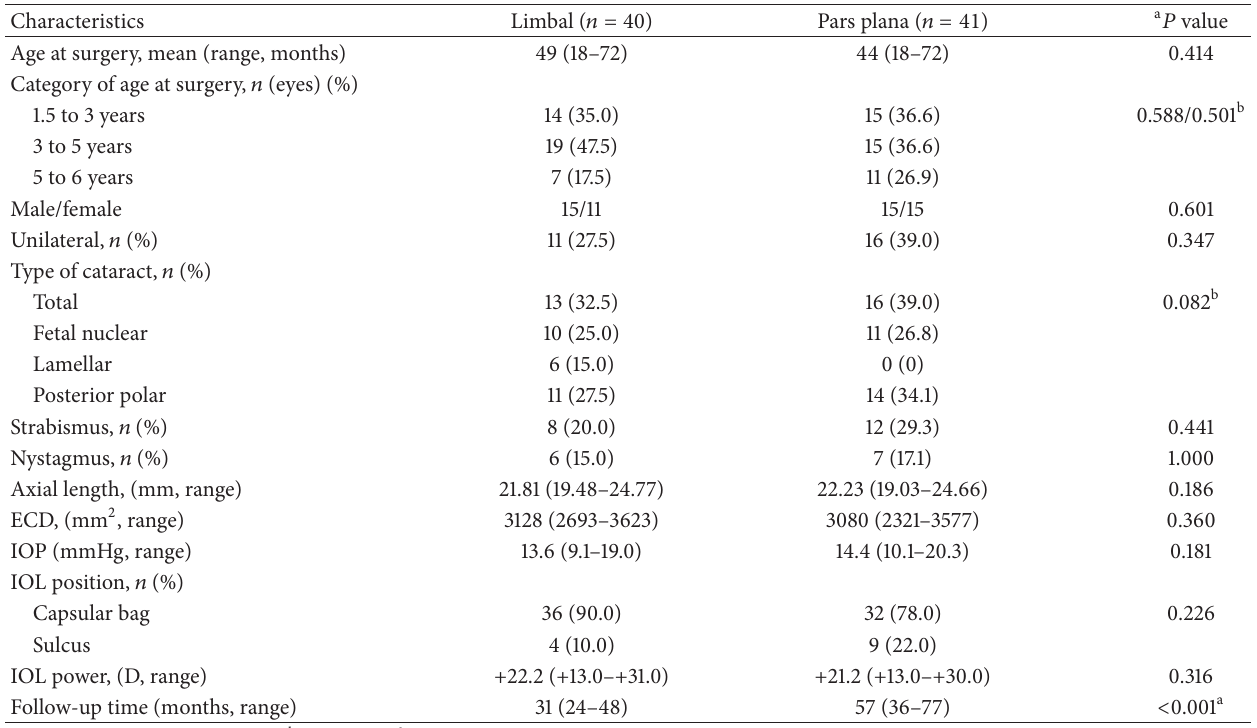
Table 1: Patient demographics.